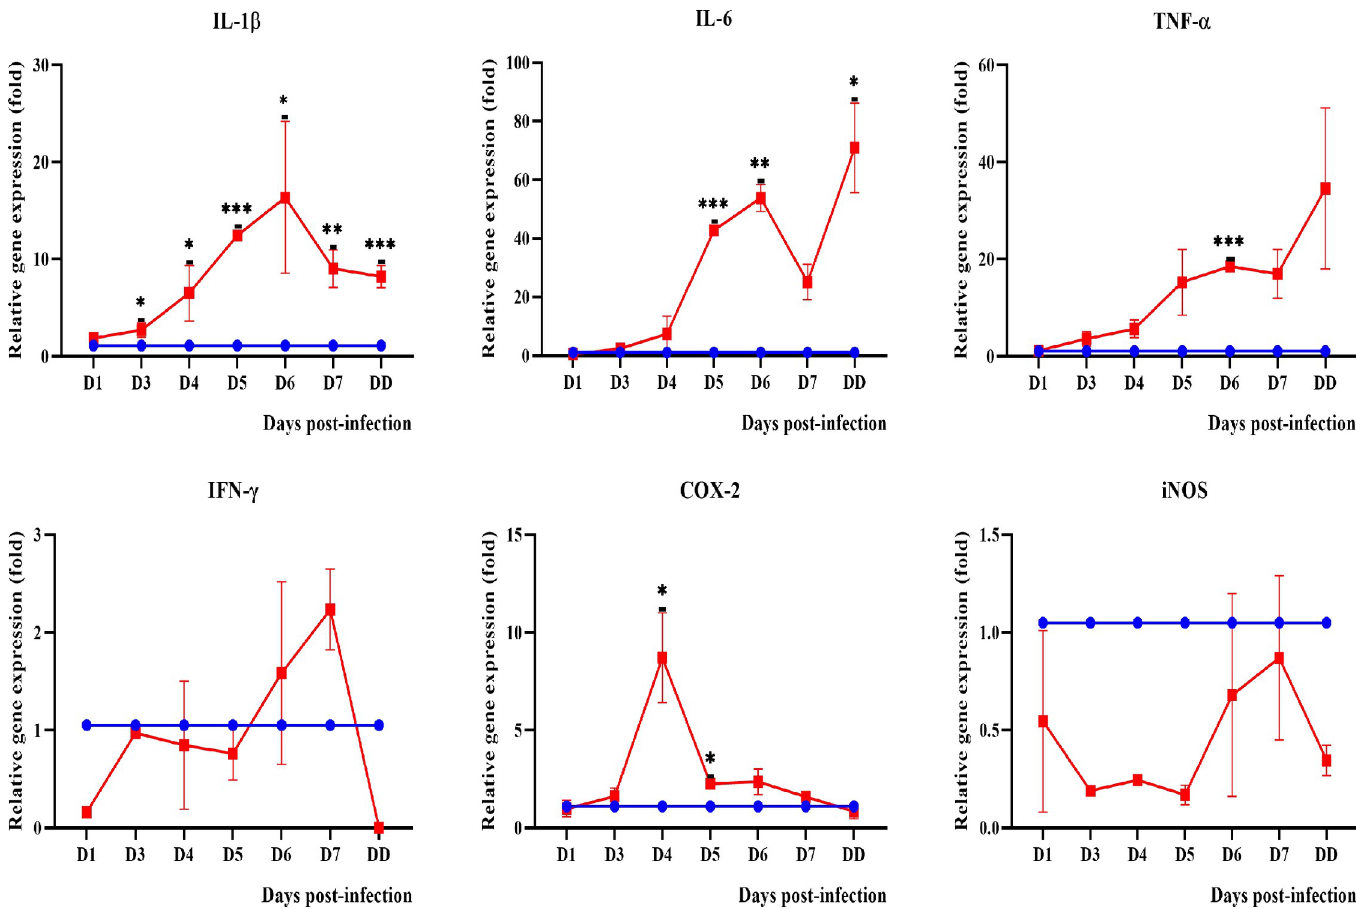
Fig 12. Modulation of pro-inflammatory cytokines and enzymes in the kidneys of control (blue line) and infected hamsters (red line). Total RNA was extracted from kidneys on day 1 p.i. and days 3 to 7 p.i. D1-D7: Day 1 to day 7. DD: dead. � P � 0.05, �� P � 0.01, ��� P � 0.001. The fold gene expression value can be found in S2 Table.